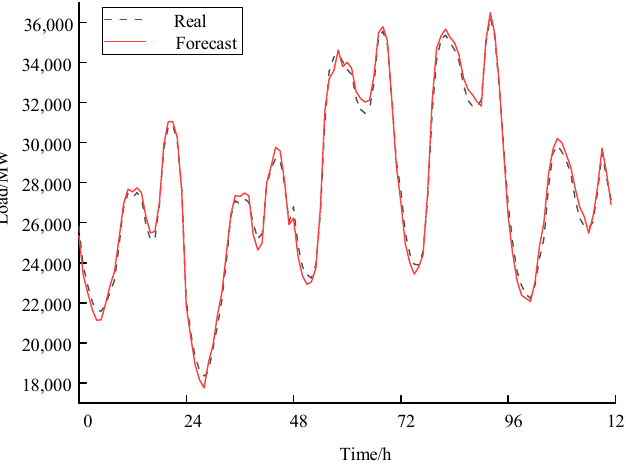
Figure 7. Forecasting results from January 31 to February 4.